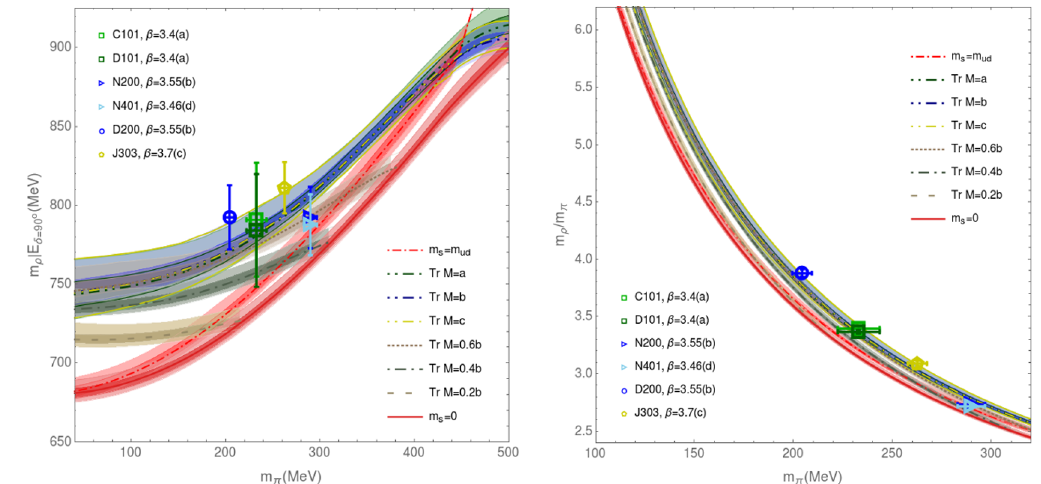
Figure 25 . The (cid:26) -meson mass (left) and normalized (cid:26) mass (respect to the pion mass) (right) as a function of the pion mass for the Tr M = C , m s = 0 and m s = m u trajectories.